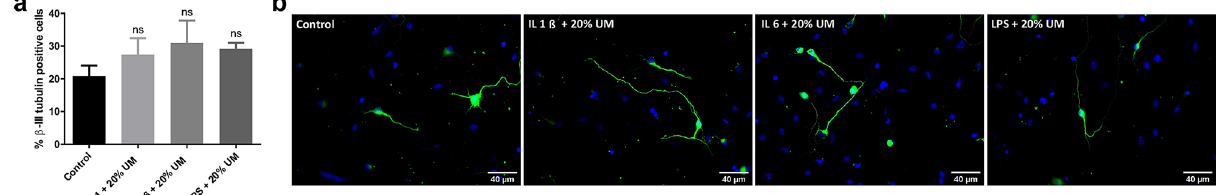
Figure 3. NSCs differentiation is not affected by ILs. ( a ) Percentage of β-III tubulin positive cells analysed by immunocytochemistry coupled to fluorescence microscopy of NSCs exposed 3 days to UM (20% V/V) supplemented with the indicated ILs (50 ng/ml) or LPS (1 µg/ml). Graph represents the percentage of neuronal differentiation measured in three independent experiments. Ns no statistical significance. ( b ) Representative